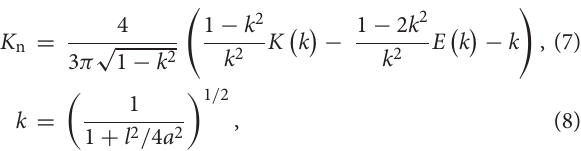
antenna, the parasitic capacitance and inductance in